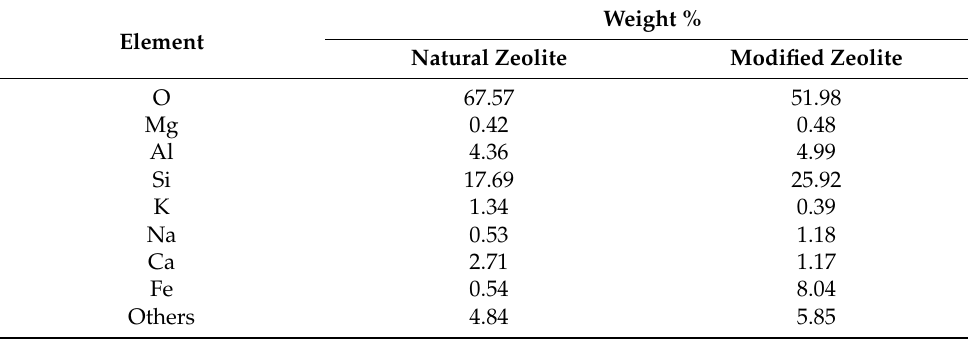
Table 2. Elemental analysis of zeolite before and after